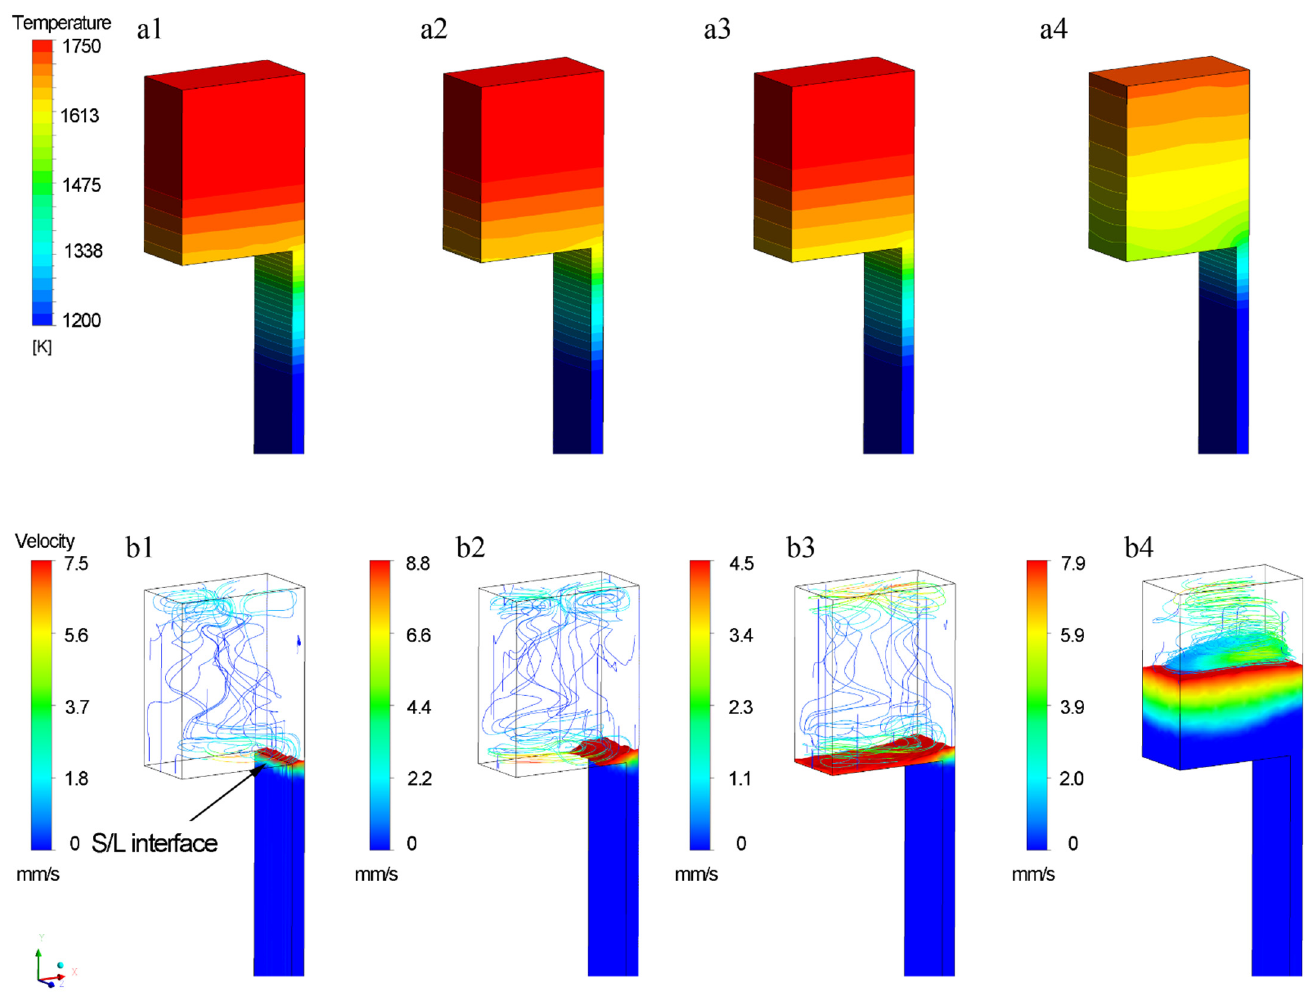
Figure 3. The contours of temperature at different times: ( a1 ) 824 s, ( a2 ) 900 s, ( a3 ) 1040 s, ( a4 ) 1280 s. ( b1 – b4 ) show the velocity streamlines and the corresponding S/L interface morphology in ( a1 – a4 ), respectively.